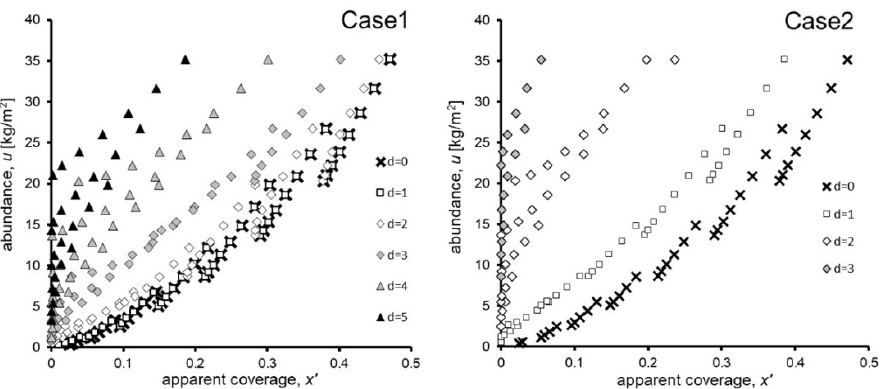
Figure 12. Relation between abundance u and apparent coverage x ′ in Cases 1 and 2. The calculated results for various values of d are plotted.